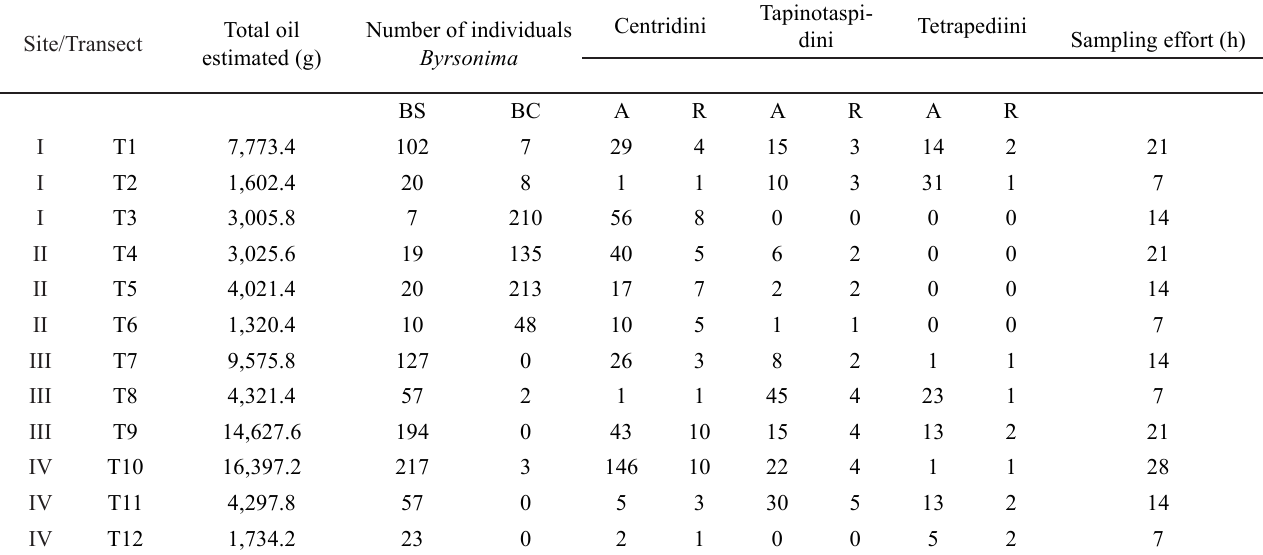
Table 3 . Abundance of the two species of Byrsonima (BS: B. sericea , BC: B. cydoniifolia ), the amount of floral oil estimated at each transect, abundance (A) and richness (R) of each tribe of oil-collecting bees per transect, sampling effort (hours) to capture bees in each transect in a cerrado area in the Chapada Diamantina, northeastern